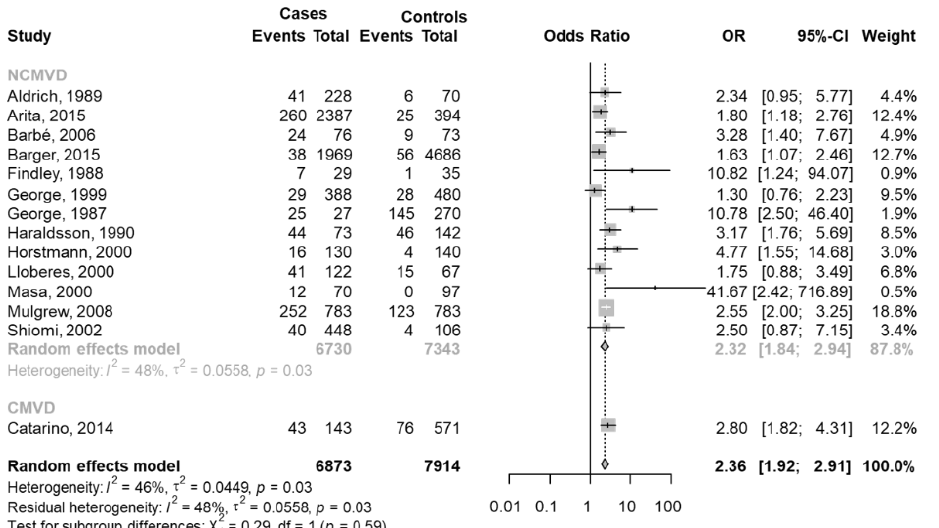
Figure 2. The forest plot of the subgroup meta-analysis of car crashes with and without OSAS based on types of drivers [40,70,41,24,25,43,45 – 48,50,52,53,65]. Events Cases are defined as car crashes with OSAS (total of 872) and Total Cases as subjects with OSAS (6873); Events Controls are defined as car crashes without OSAS (total 538) and Total Controls as subjects without OSAS (7914). In each group, a diamond represents the pooled OR estimate based on the random effects model.